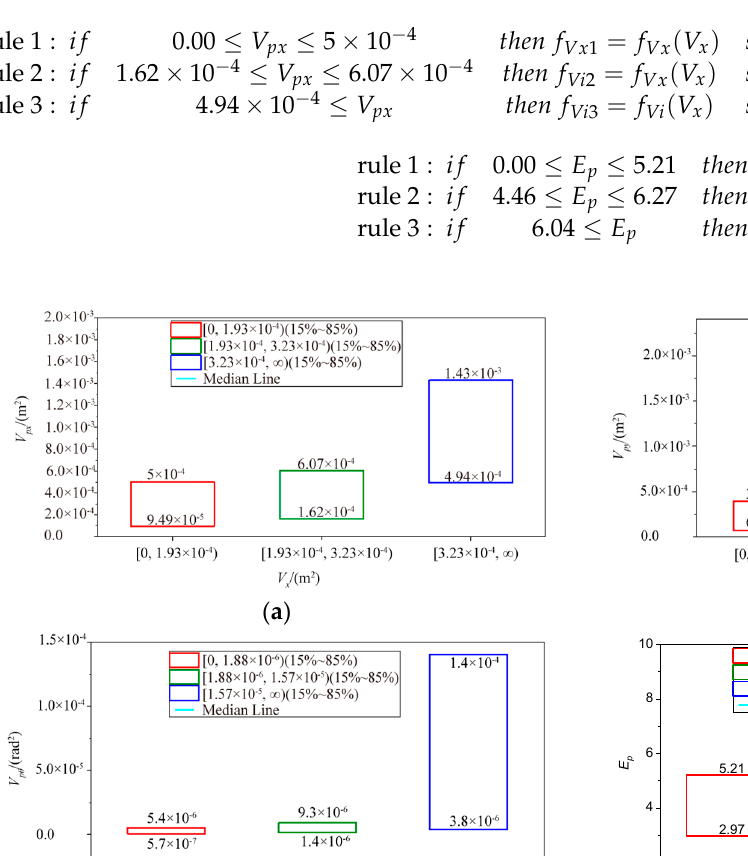
V in px V . ( c ) V θ in the different y p